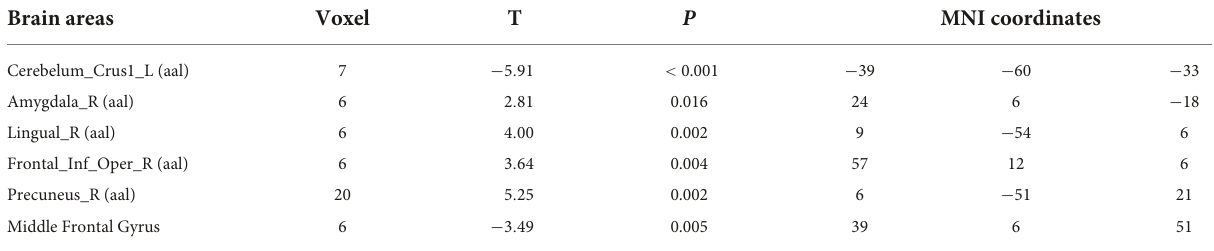
TABLE 5 Differences in brain regional homogeneity (ReHo) among participants in test 3 for the rehydration state with participants in the dehydration state in test 2. Brain areas Voxel T P MNI